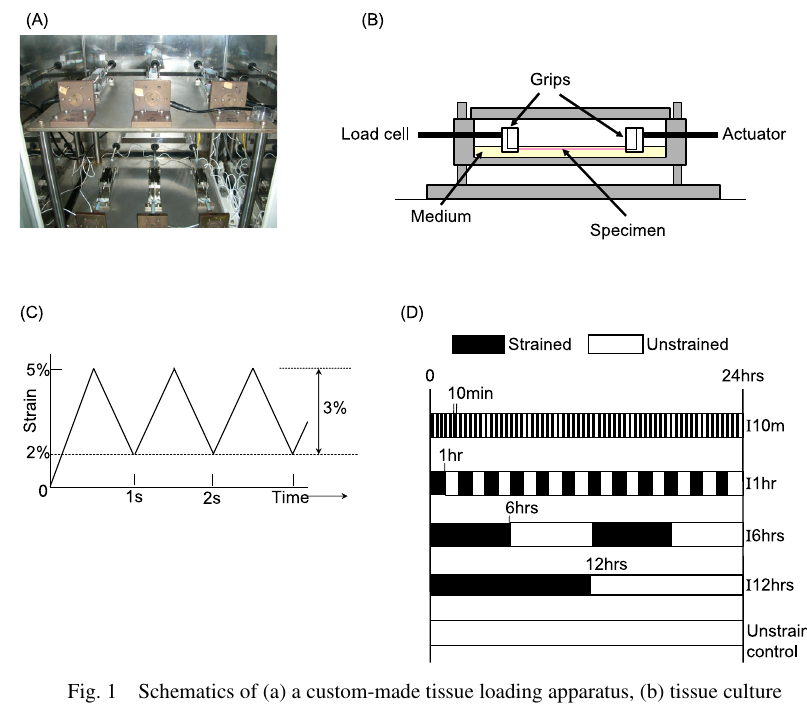
Fig. 1 Schematics of (a) a custom-made tissue loading apparatus, (b) tissue culture chamber used for stimulating samples, (c) cyclic tensile strain and (d) intermittent strain